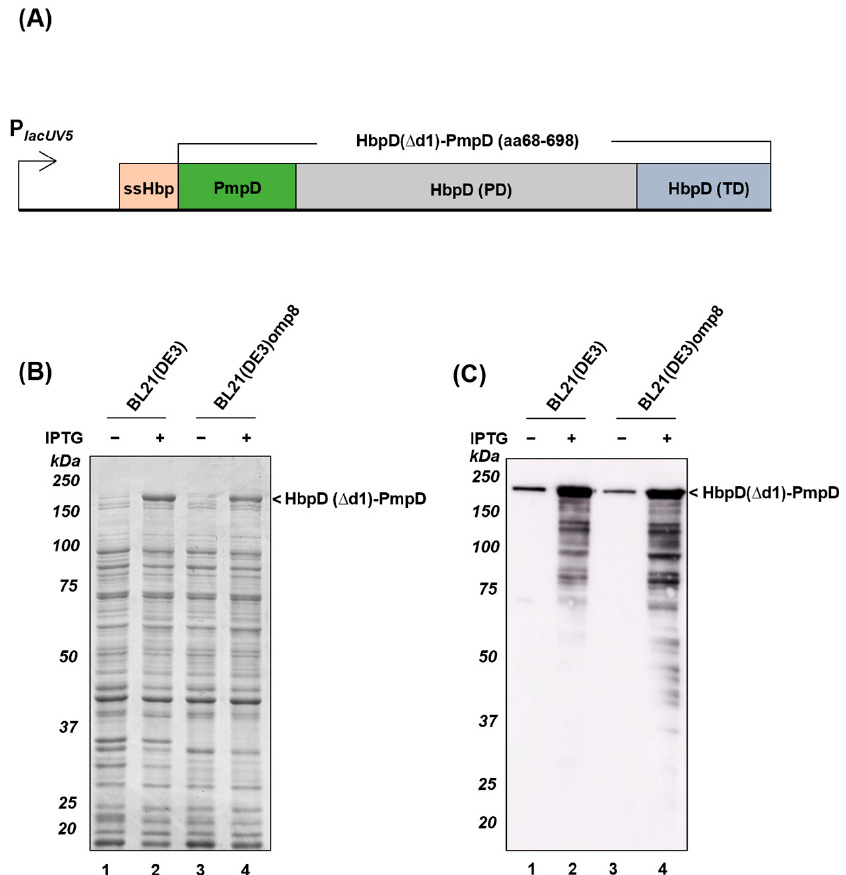
Figure 2. Expression of HbpD( ∆ d1)-PmpD in different E. coli strains. ( A ) Schematic representation of the HbpD( ∆ d1)-PmpD (aa68-698) construct in which truncated PmpD (aa68-698) was fused to the HbpD( ∆ d1)-based platform and expressed under control of the lacUV5 promoter. ( B , C ) BL21(DE3) and BL21(DE3)omp8 cells were induced for HbpD( ∆ d1)-PmpD expression with (+) or without ( − ) 0.1 mM IPTG for 2 h and whole cells were analyzed by SDS-PAGE/Coomassie staining ( B ) and immunoblotting using antiserum against PmpD ( C ). MW markers (in kDa) are indicated at the left and identified protein bands at the right side of panels.